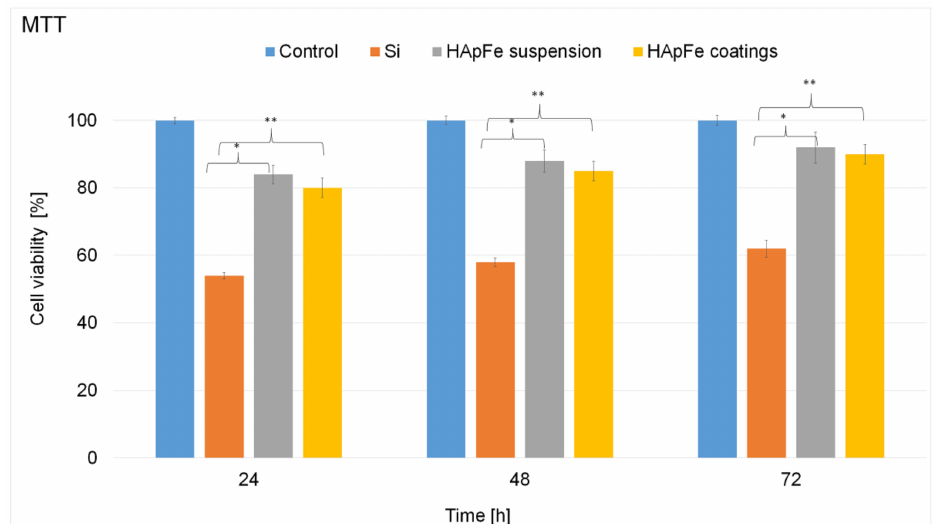
Figure 8. MTT assay of the viability of osteoblast cells incubated with Si discs and HApFe suspensions and coatings for 24, 48, and 72 h. Control is represented by an osteoblast cell culture grown on polystyrene Petri dish. The results are presented as means ± standard error. The data were statistically analyzed using paired and two-sample t -tests for means, with p ≤ 0.05 accepted as statistically significant (* p ≤ 0.005; ** p ≤